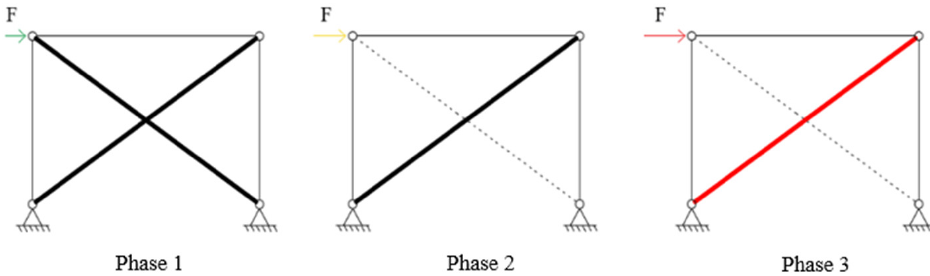
Figure 1. Schematization of the three phases of a X-CBF response under an increasing load; phase 1: elastic behavior with both diagonals active; phase 2: elastic behavior with a single active diagonal; phase 3: plastic phase.